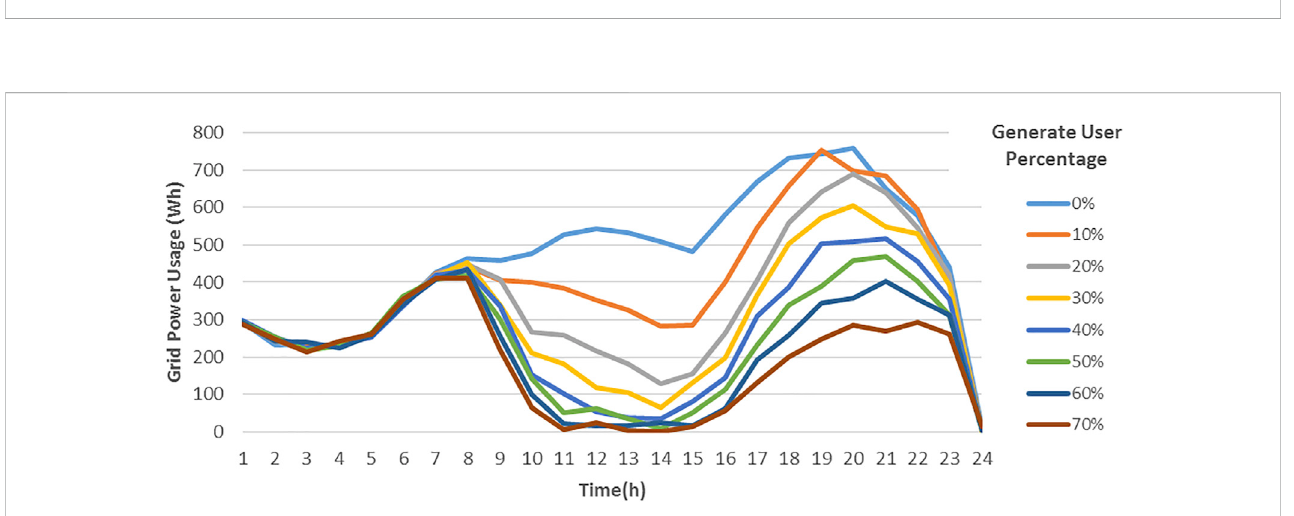
FIGURE 9 Grid power usage with different generated user percentages.